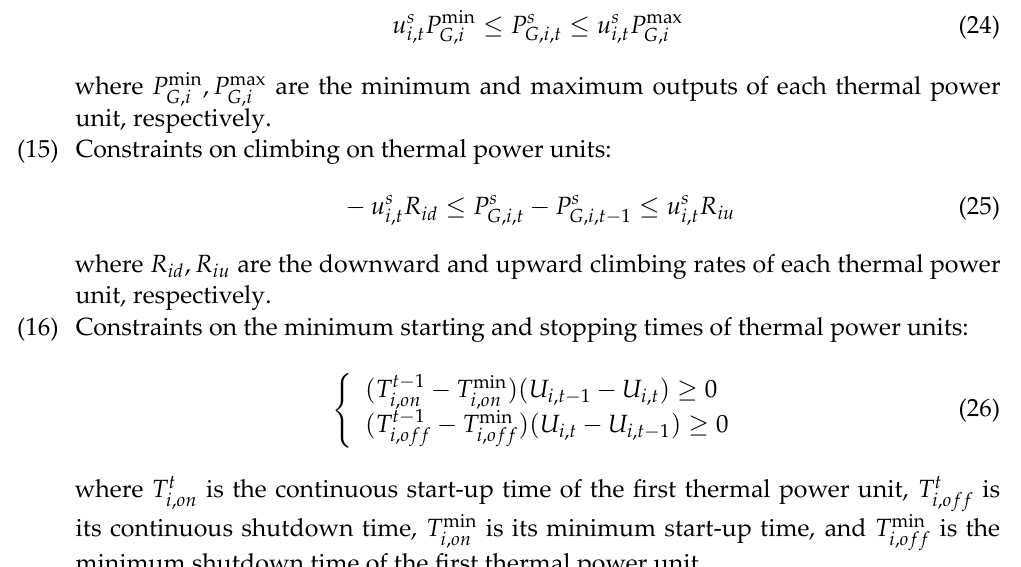
14.1 Table 2. Operating parameters of optimal thermal power station. Operational Parameters of CSP Station